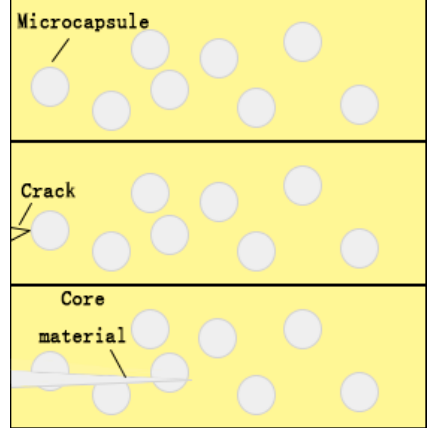
Figure 1. The repair process of crack.